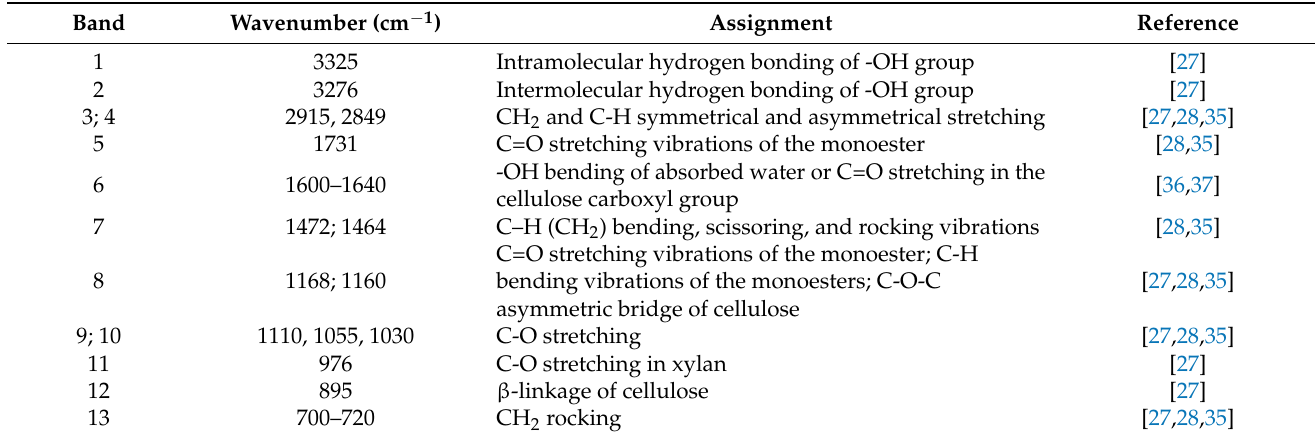
Table 1. Assignments of the infrared absorption